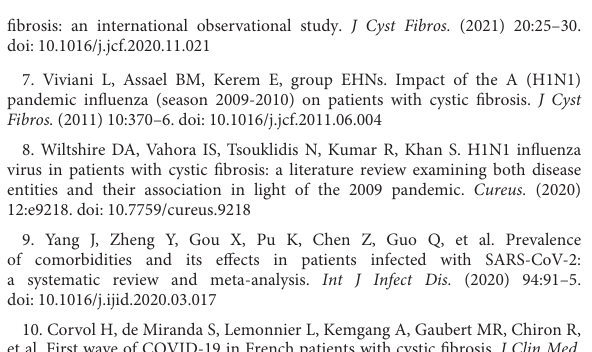
SUPPLEMENTARYFIGURE2 Number of patients hospitalized for COVID-19 on May 24th, 2020 in the different geographic regions of France. SUPPLEMENTARYTABLE1 Repartition of CF patients among the different geographic metropolitan regions of France. SUPPLEMENTARYTABLE2 COVID-19 disease and beliefs about the risk of COVID-19